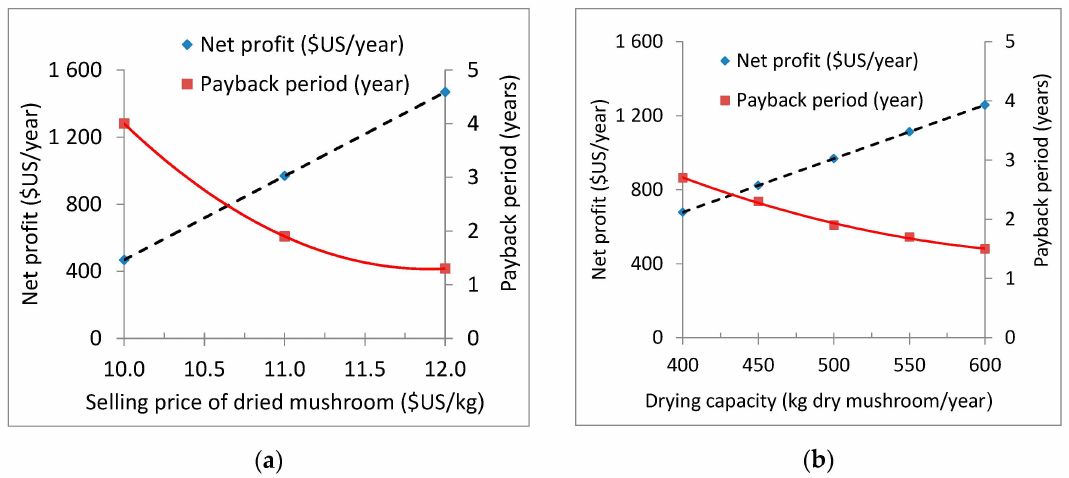
Figure 8. ( a ) E ff ects of dry mushroom selling price on the net profit and payback period of a service using SBD for mushroom drying; ( b ) e ff ects of drying capacity on the net profit and payback period of a service using SBD for mushroom